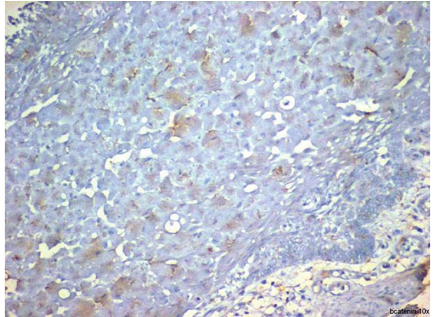
Figure 8: Expression of 𝛽 -catenin was generally weak, except for only the focal areas that showed a moderate staining intensity and weak in peripheral cells